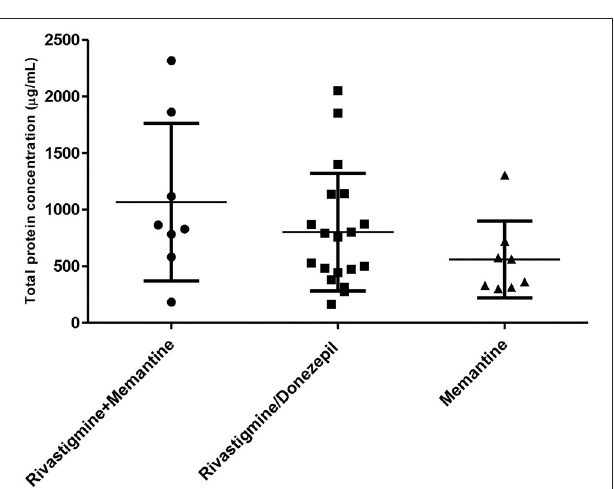
Supplementary Figure 6 | Total protein concentration measured in the subgroups of patients with different pharmacological treatment.